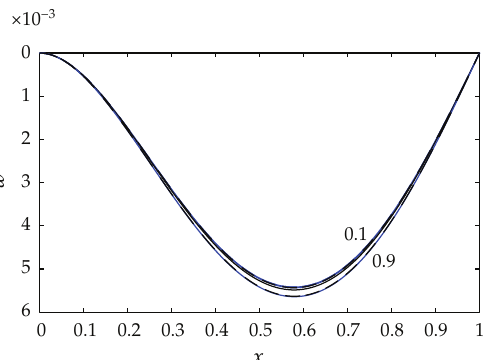
Figure 8: Comparison of the asymptotic expansion (cid:3) 5.1 (cid:4) correct to order B 2 (cid:3) - - - (cid:4) with the exact solution (cid:3) 4.3 (cid:4) (cid:3) — (cid:4) of the deflection w (cid:3) x (cid:4) for B (cid:5) 0 . 1 , 0 . 25 , 0 . 5 , 0 . 9. The curves for the exact solution and asymptotic solution